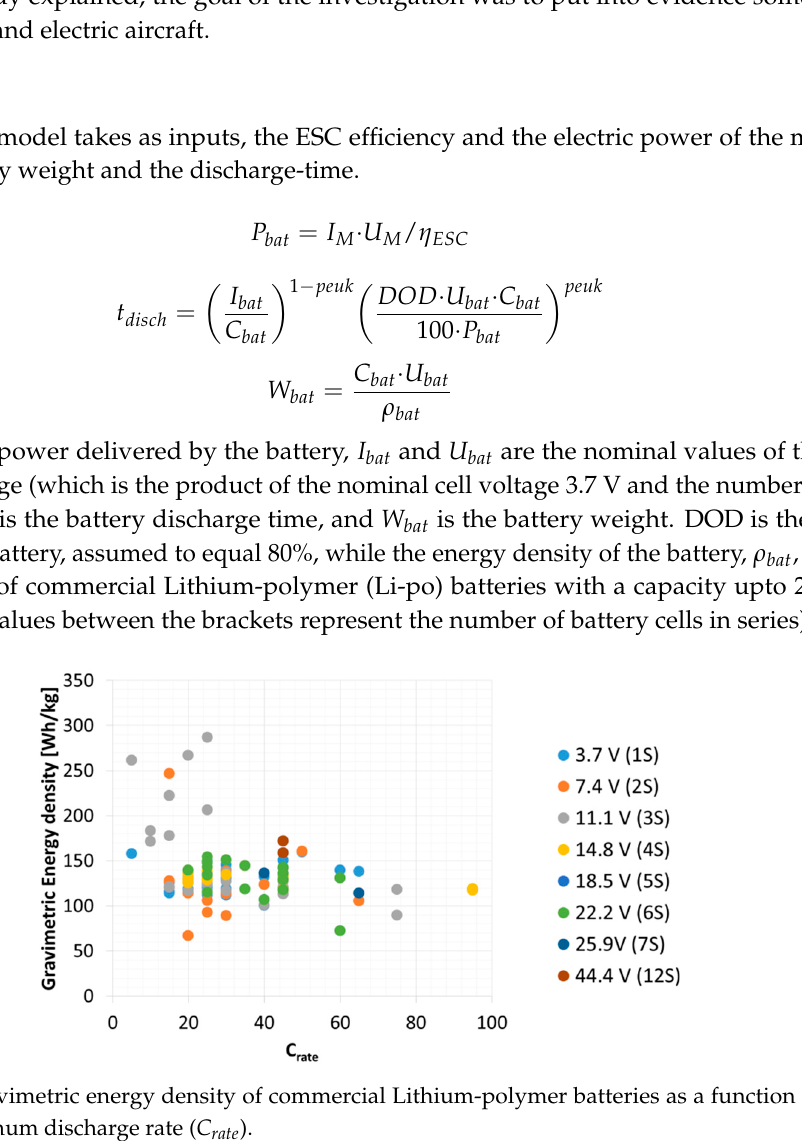
Figure 3. Gravimetric energy density of commercial Lithium-polymer batteries as a function of the battery maximum discharge rate ( C rate ) .